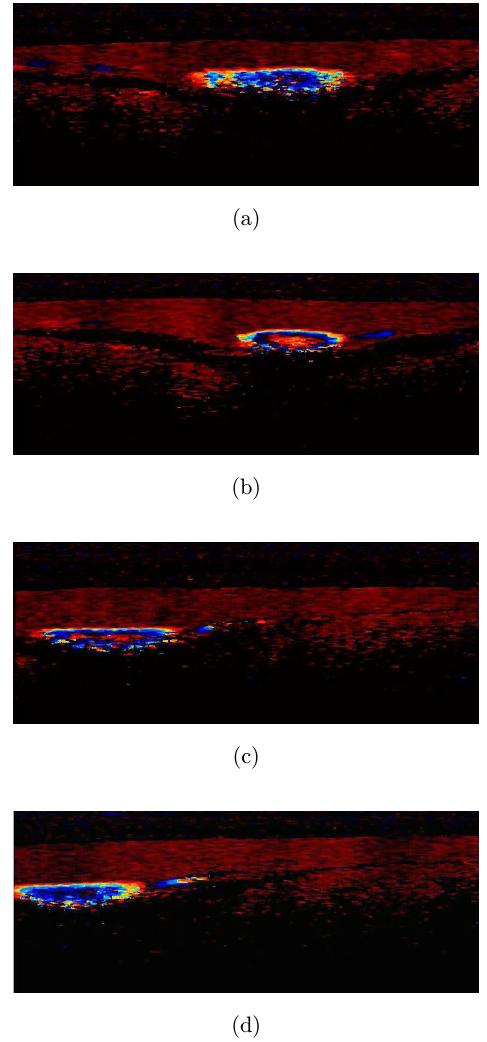
Fig. 4. Responses of the sagittal vein to adrenaline for a healthy rat (a) and (b) and a rat with IH (c) and (d). Baseline DOCT images are shown in (a) and